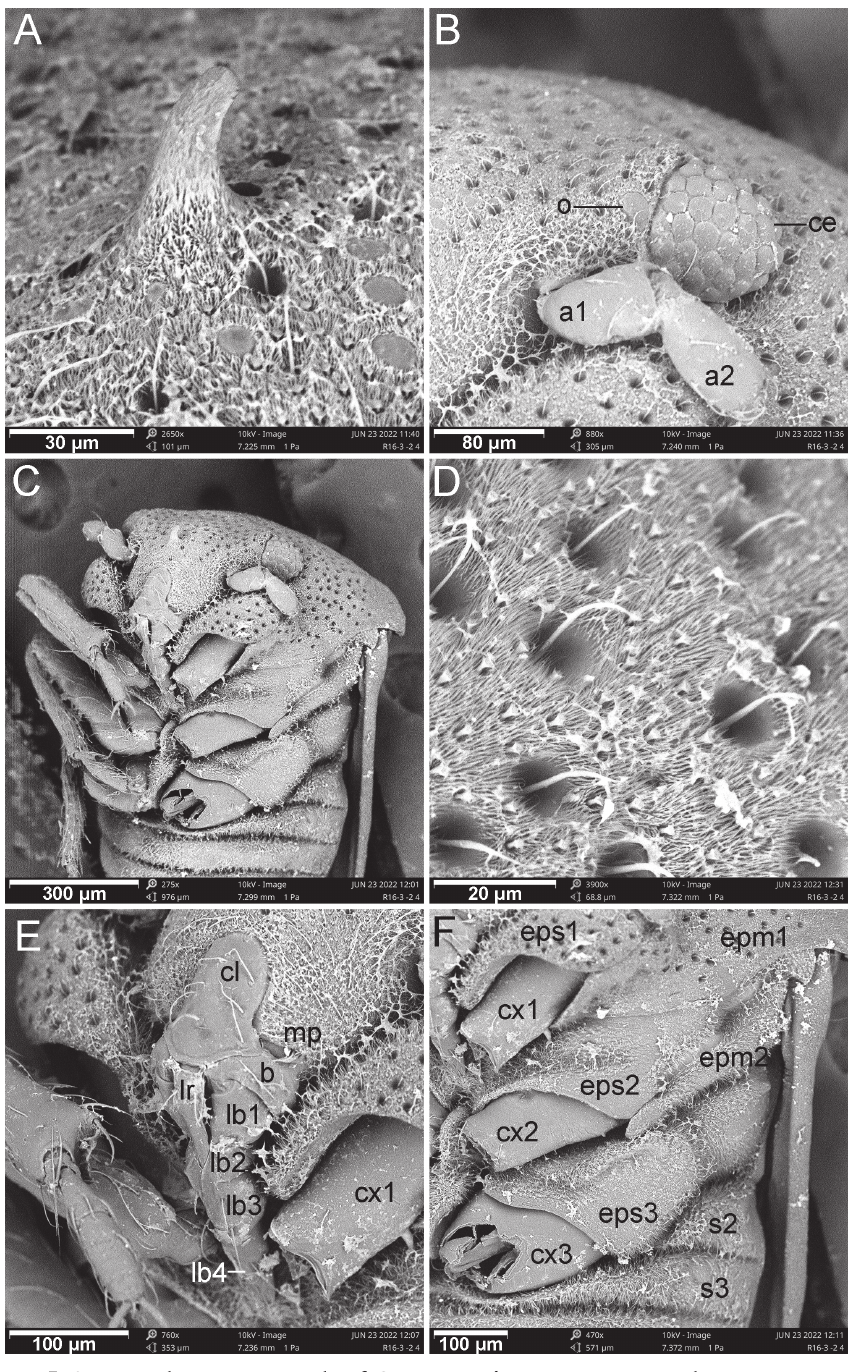
Figure 5. Scanning electron micrographs of Cornonannus bui gen. et sp. nov., male paratype in ventro- lateral view A frontal process B left eye and ocellus C head and thorax D microtrichia on head E mouth parts F